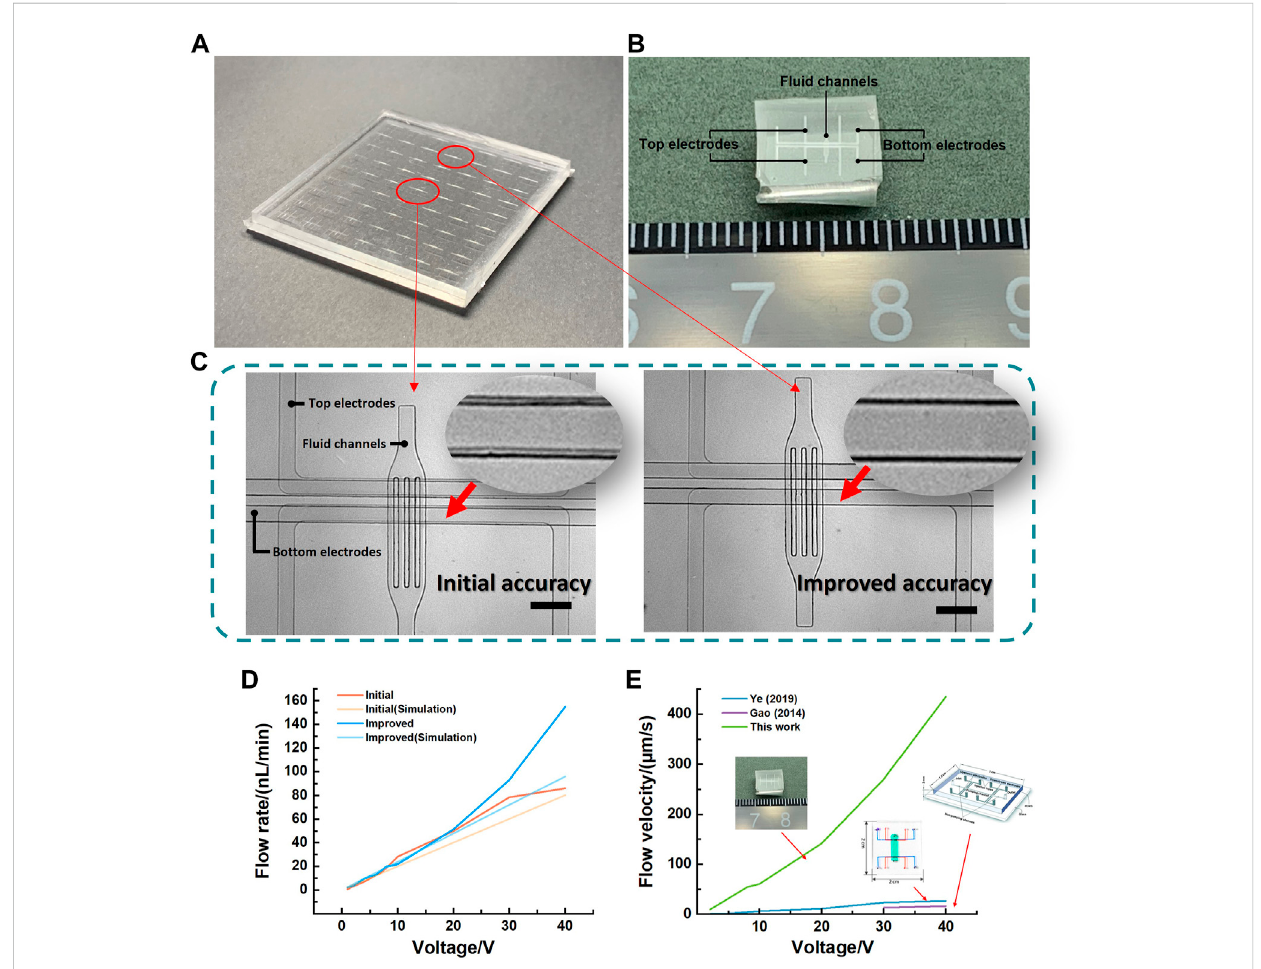
FIGURE 7 (A) Pictureofthebonded3Dmicropumpchipincludingtwoelectrodelayersanda fl uidlayerwith7×9micropatternsoneachlayer. (B) Comparison of central pump and optimally aligned pump. Scalebar is 300 µm. (C) Optical photograph of the separated micropump chip after alignment. (D) Comparison of fl owrates from 1 V to 40 V for theoptimally improved micropump and the initial micropump and their simulation results. (E) Comparison of this work with Gao ’ s (Gao and Gui, 2014) and Ye ’ s work (Ye et al., 2019) with similar